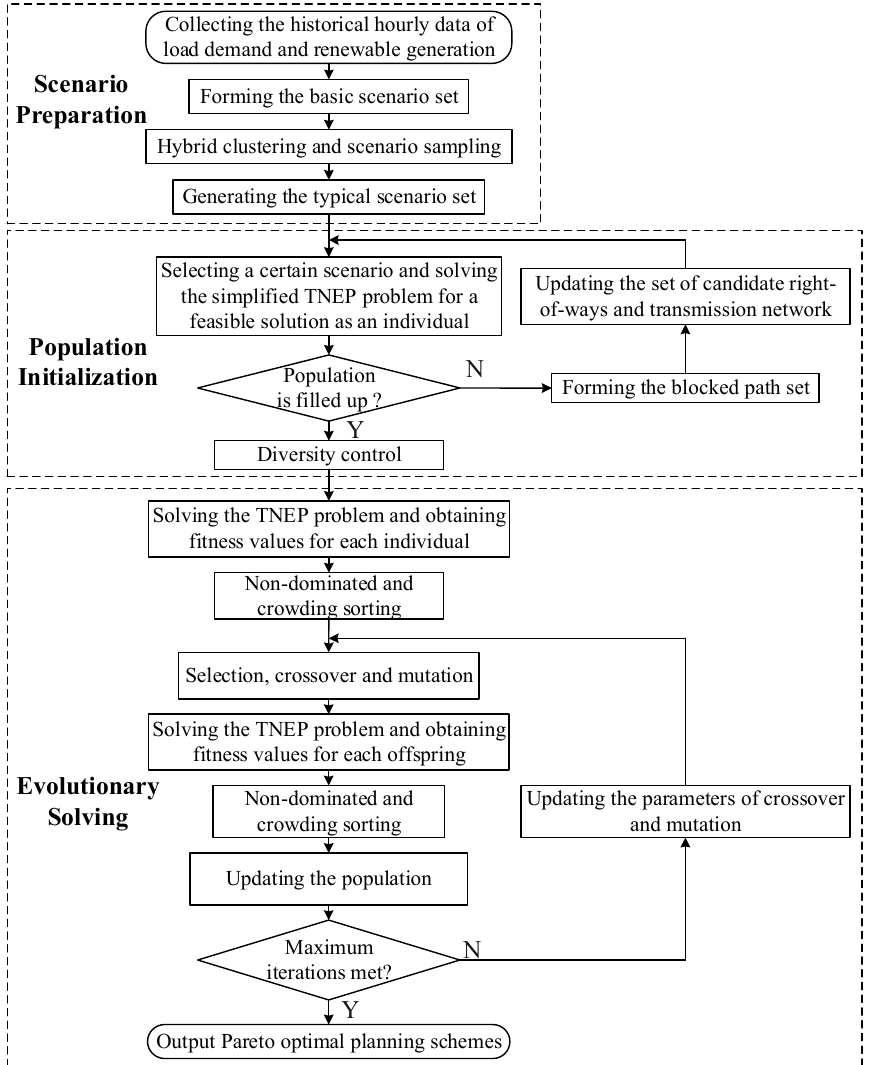
Figure 4. The solving process of TNEP problem by the modified NSGA-II.